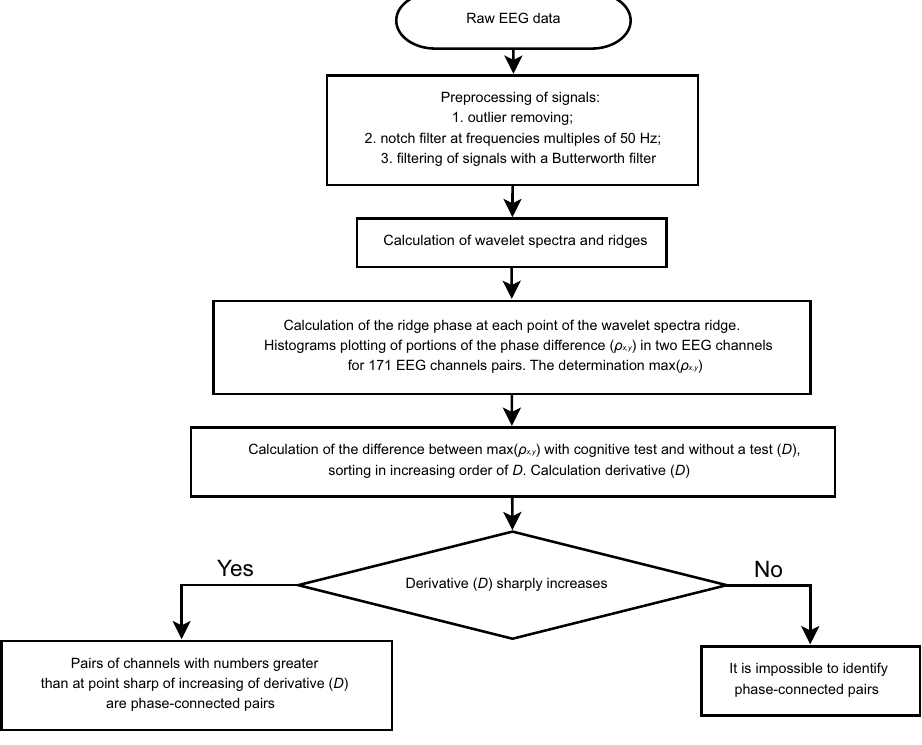
Figure 14. The block diagram of the developed algorithm for the determination of phase-connected EEG